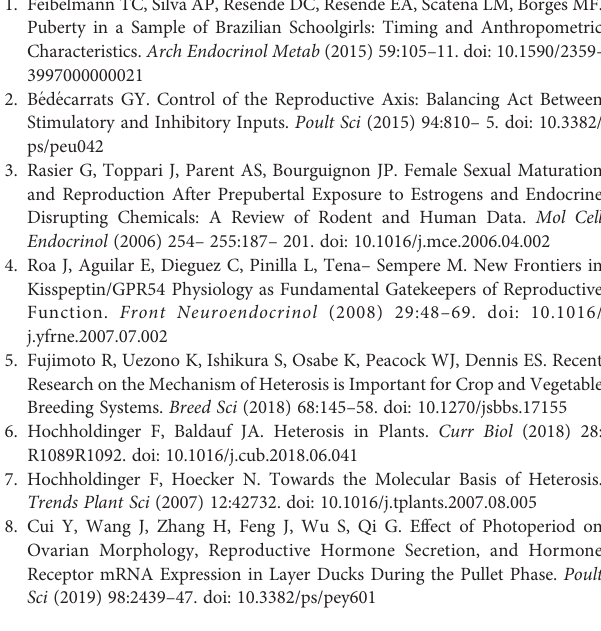
Supplementary Table 2 | The results of differentially expressed lncRNAs and differentially expressed genes in different groups. Supplementary Table 3 | Classi fi cation of different expression patterns of mRNAs and lncRNAs. Supplementary Table 4 | The enriched GO terms and pathways of nonadditive genes and detailed information of the shared nonadditive genes enriched in key biological